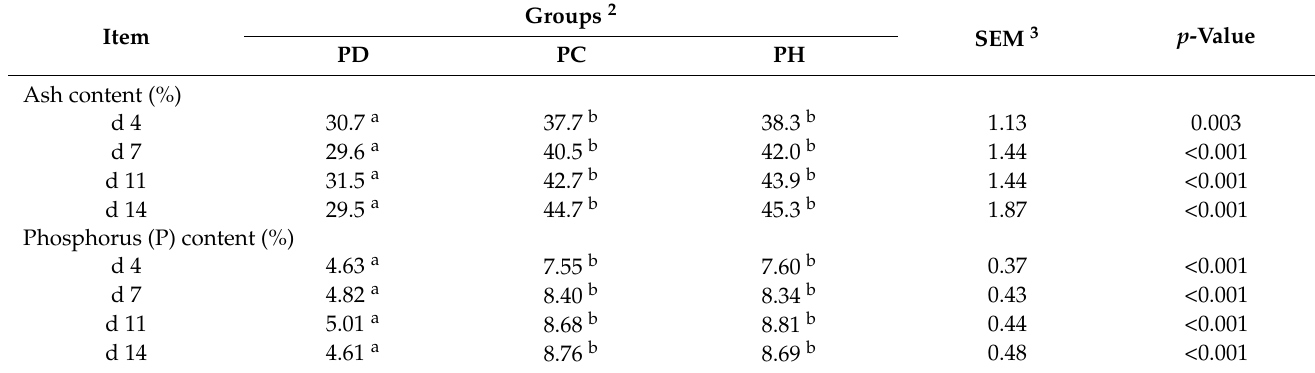
Table 7. Effects of dietary phosphorus (P) deficiency and high P content on the content of ash, calcium (Ca), and P in the tibia in